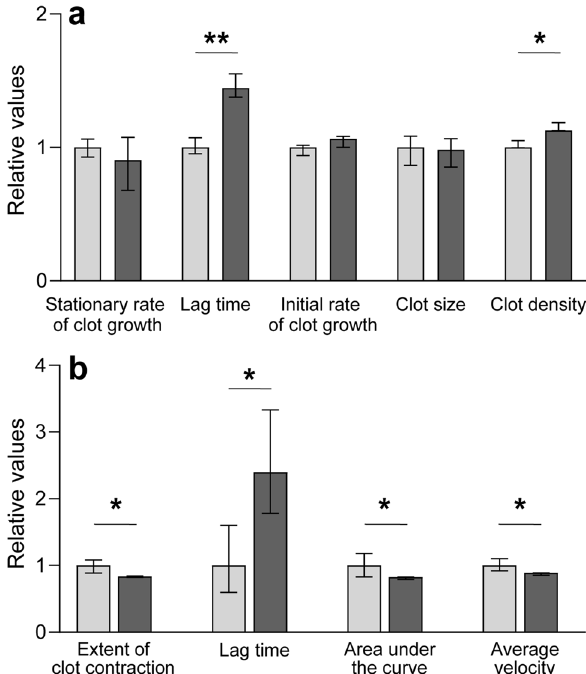
Figure 1. Parameters of thrombodynamics ( a ) and kinetics of blood clot contraction ( b ) in COVID-19 patients normalized by the values for healthy subjects (the median taken as 1). Grey bars—healthy subjects (n = 20 for a and 40 for b ); dark bars—patients with COVID-19 (n = 200 for a and 215 for b ). The results are presented as median and interquartile range (25th and 75th percentiles). *p < 0.05; ** p < 0.01; Mann–Whitney